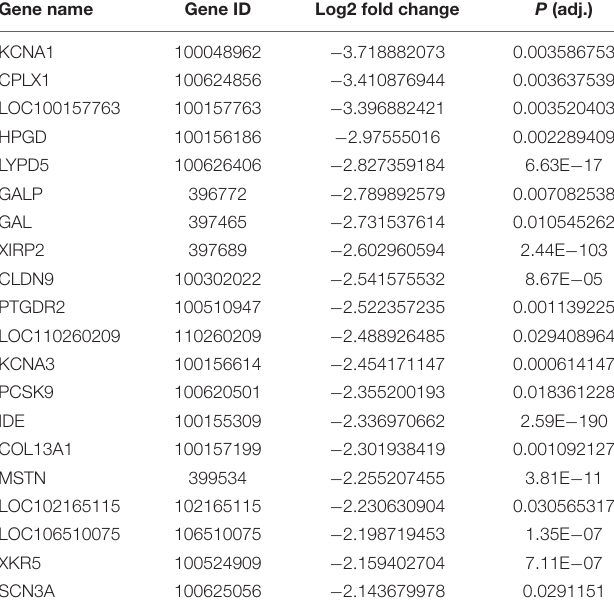
TABLE 2 | Top 20 downregulated differentially expressed